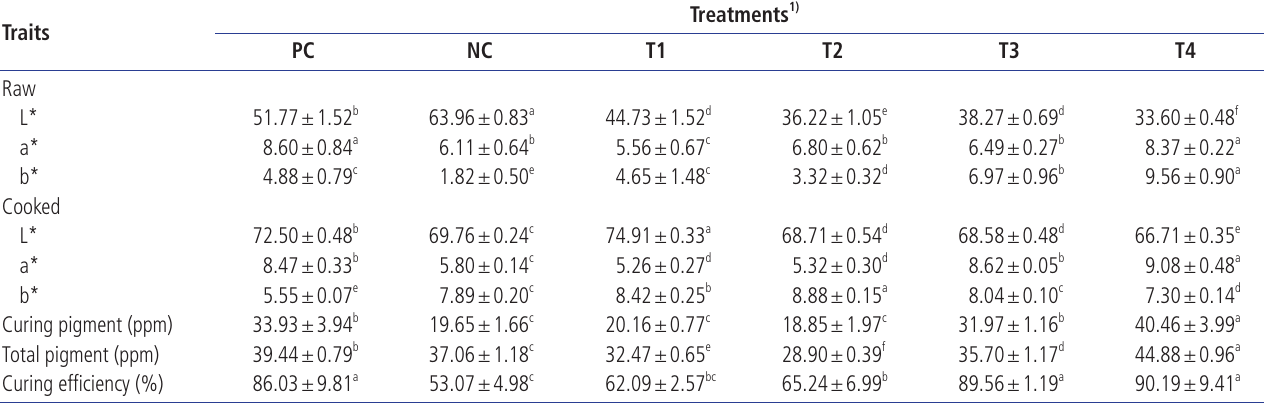
Table 3. Color characteristics and curing efficiency of cured pork loin with natural nitrite source from fermented Swiss chard (FSC)